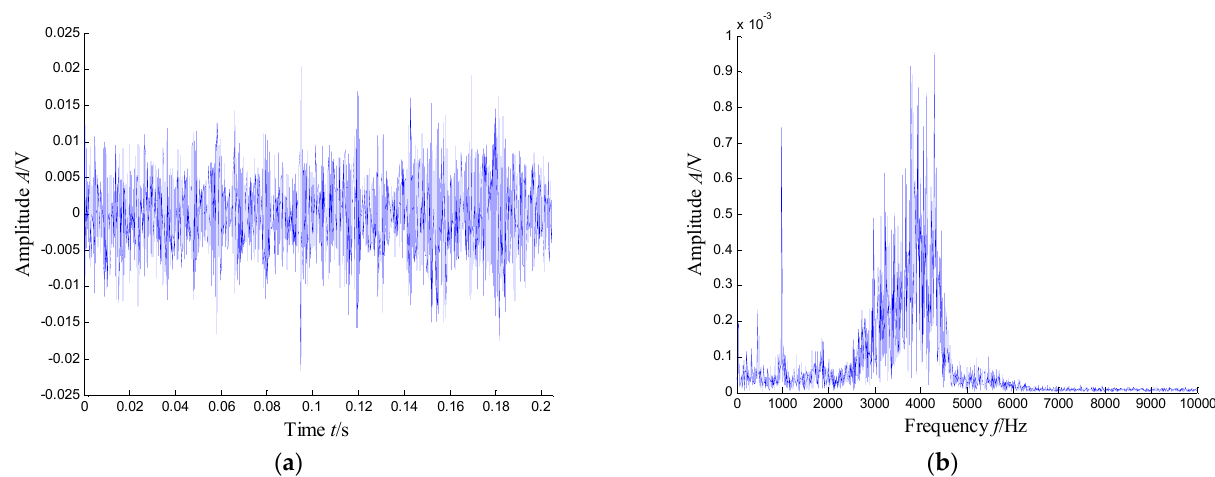
Figure 17. Waveform and spectrum of the extracted signal: ( a ) waveform of the extracted signal and ( b ) spectrum of the